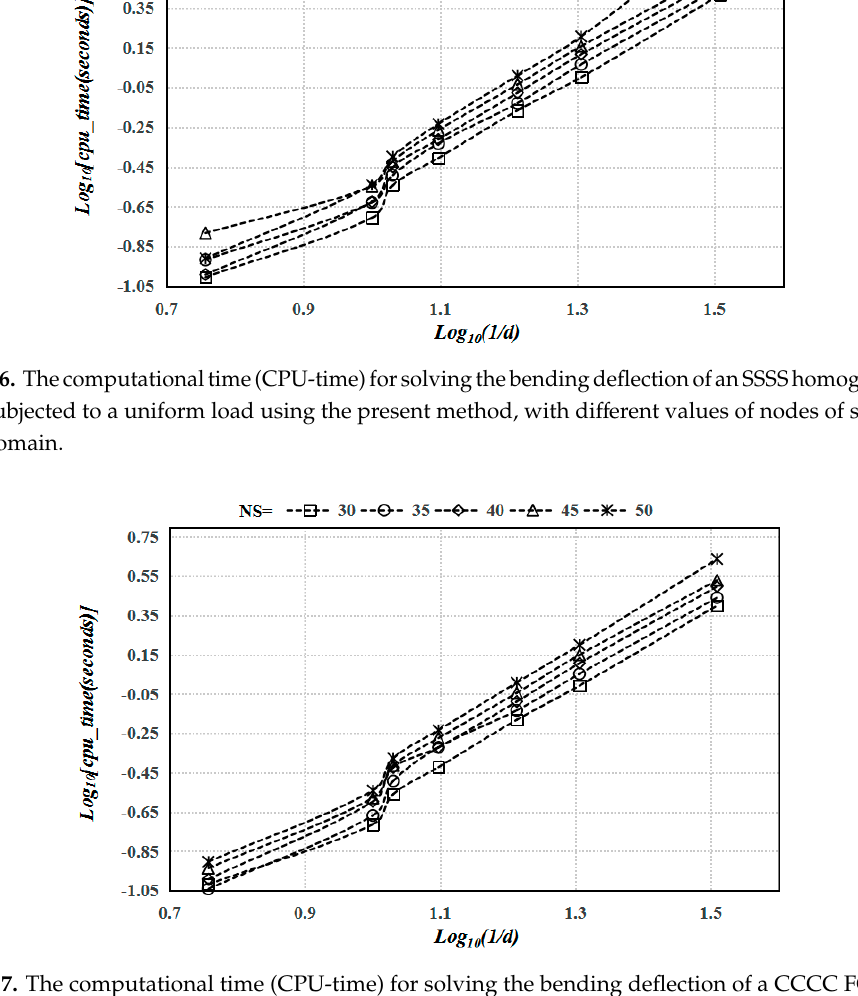
Figure 8. The relative deviation, based on the IGA [39] in Table 2 versus 8 × 8, 12 × 12, 16 × 16, 20 × 20, and 32 × 32 nodes (grids), including the finite element method, with node-based strain smoothing [38] and the present method.